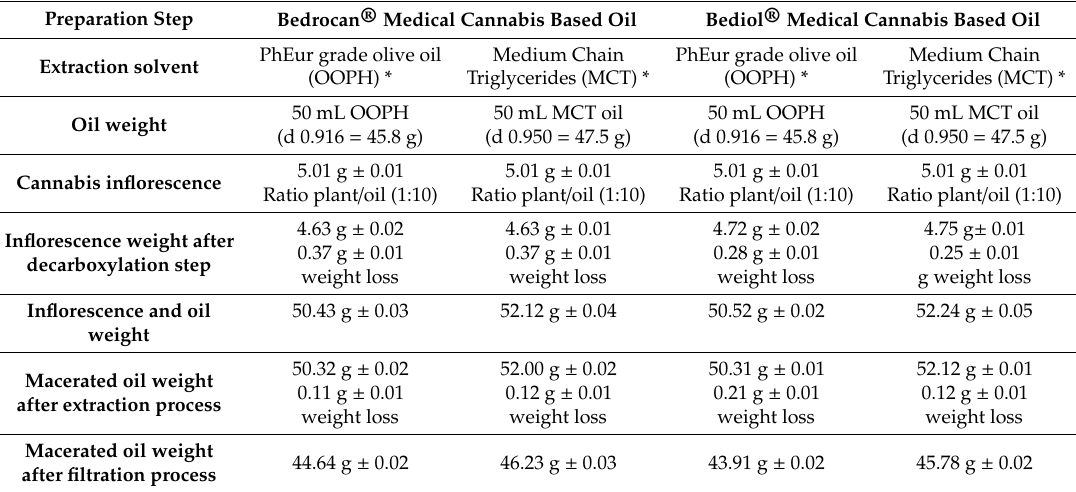
Table 2. Cannabis parameter variation during oil preparation according to the di ff erent lipid sources